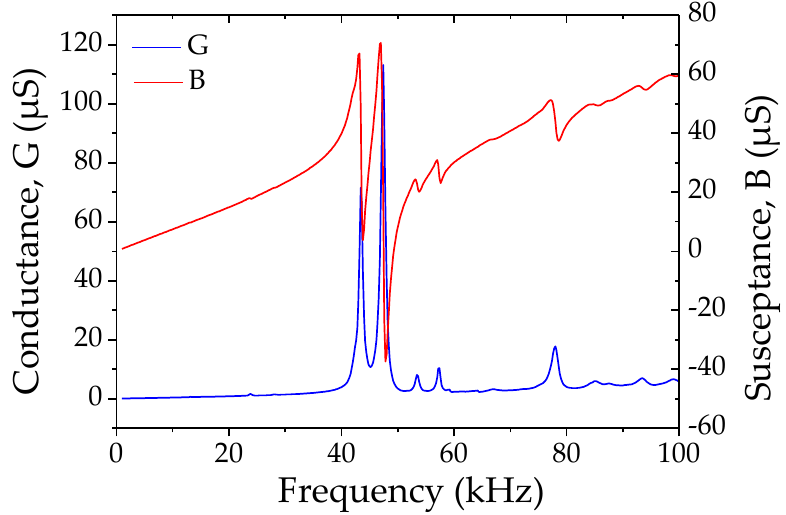
Figure 7. Conductance and susceptance spectra of 2.5 mm thick RS/PLA manufactured sample.